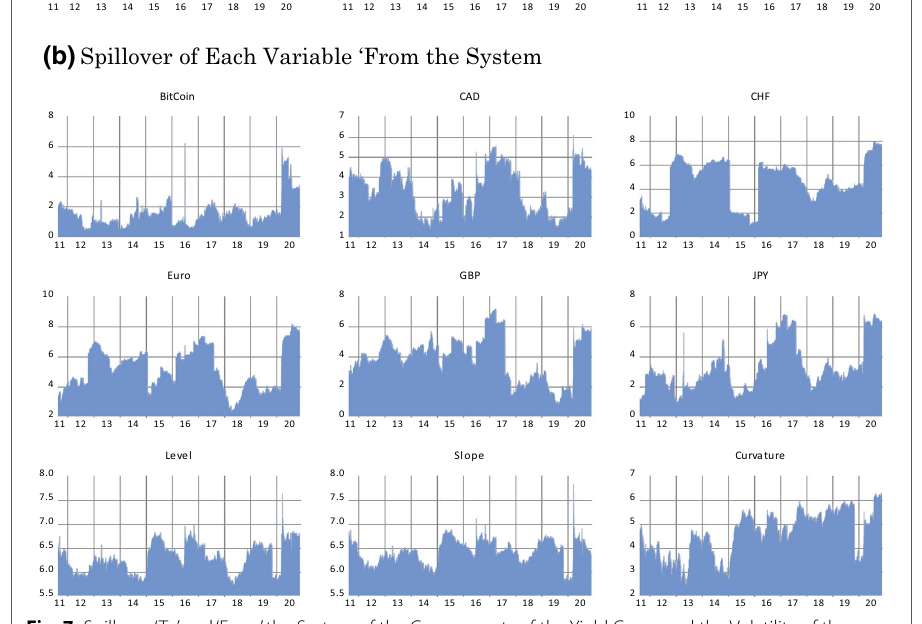
Fig. 7 Spillover ‘To’ and ‘From’ the System of the Components of the Yield Curve and the Volatility of the Exchange Rates of the Safe Haven Currencies and Bitcoin. a Spillover of Each Variable ‘TO’ the System. b Spillover of Each Variable ‘From the System. Notes : The figures describe the dynamic ‘TO’ and ‘FROM” spillovers between each variable and the whole system comprising the yield curve components and the volatility of the exchange rate of Bitcoin and the safe haven currencies. The rest of the notations are as in Fig.